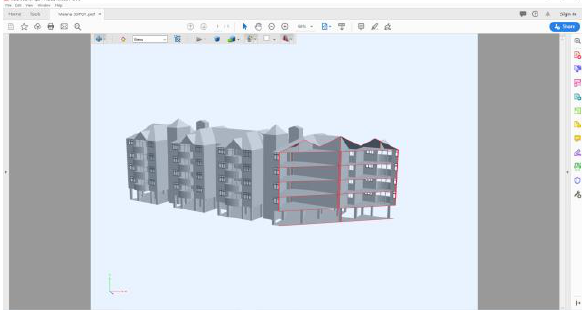
Figure 6. The cross-section view in 3D